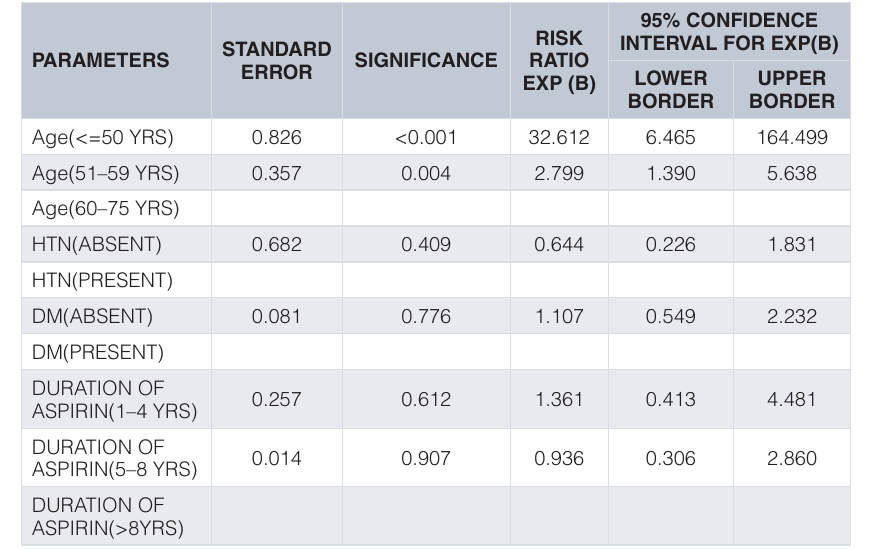
Table 3. Regression analysis of age, duration of aspirin intake, hypertension (HTN) and diabetes (DM) with tinnitus (182